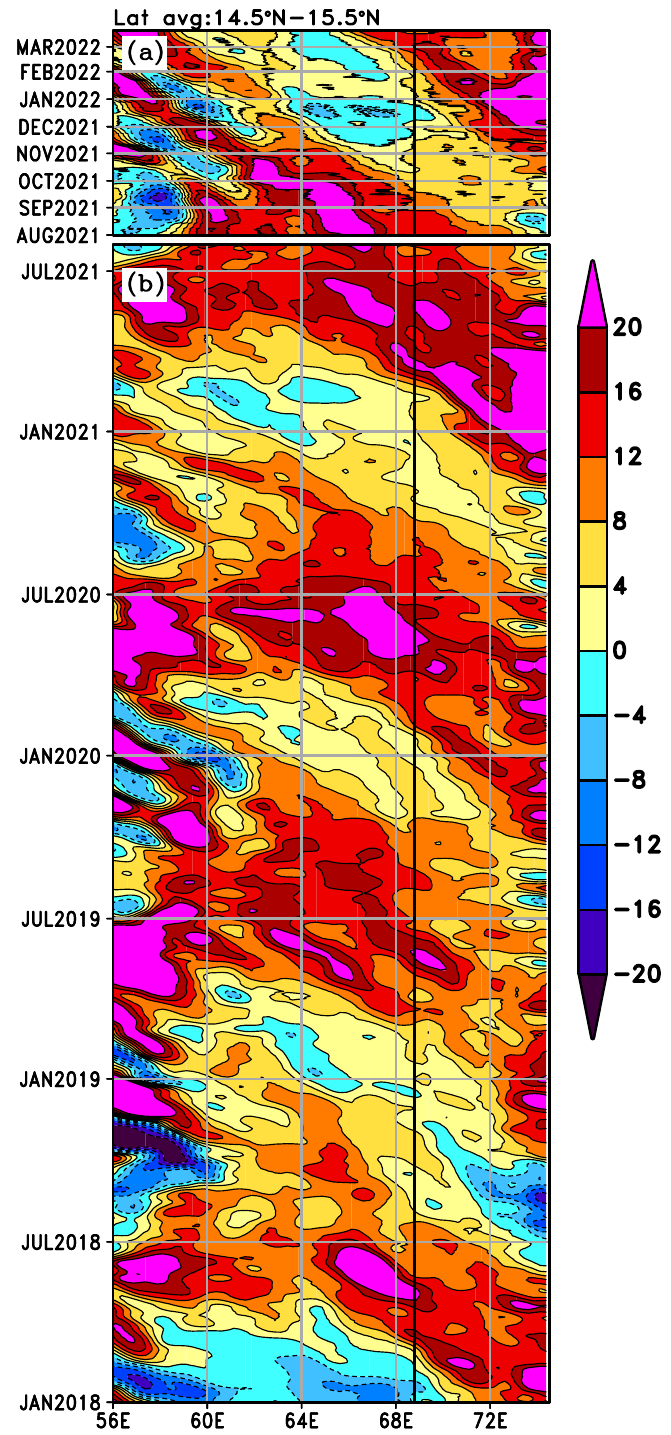
Figure 3. Hovemoller diagram depicting SLA averaged in latitudes from 14.5° N to 15.5° N in the Arabian Sea ( a ) Near Real-Time SLA from August 2021 to March 2022 and ( b ) Delayed Time SLA from January 2018 to July 2021. Black vertical lines in the figure indicate the longitude of the moored